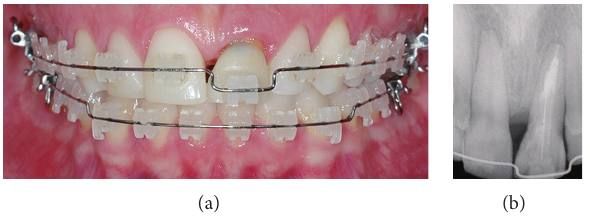
Figure 5: (a, b) Radiographic and clinical images illustrating orthodontic extrusion.